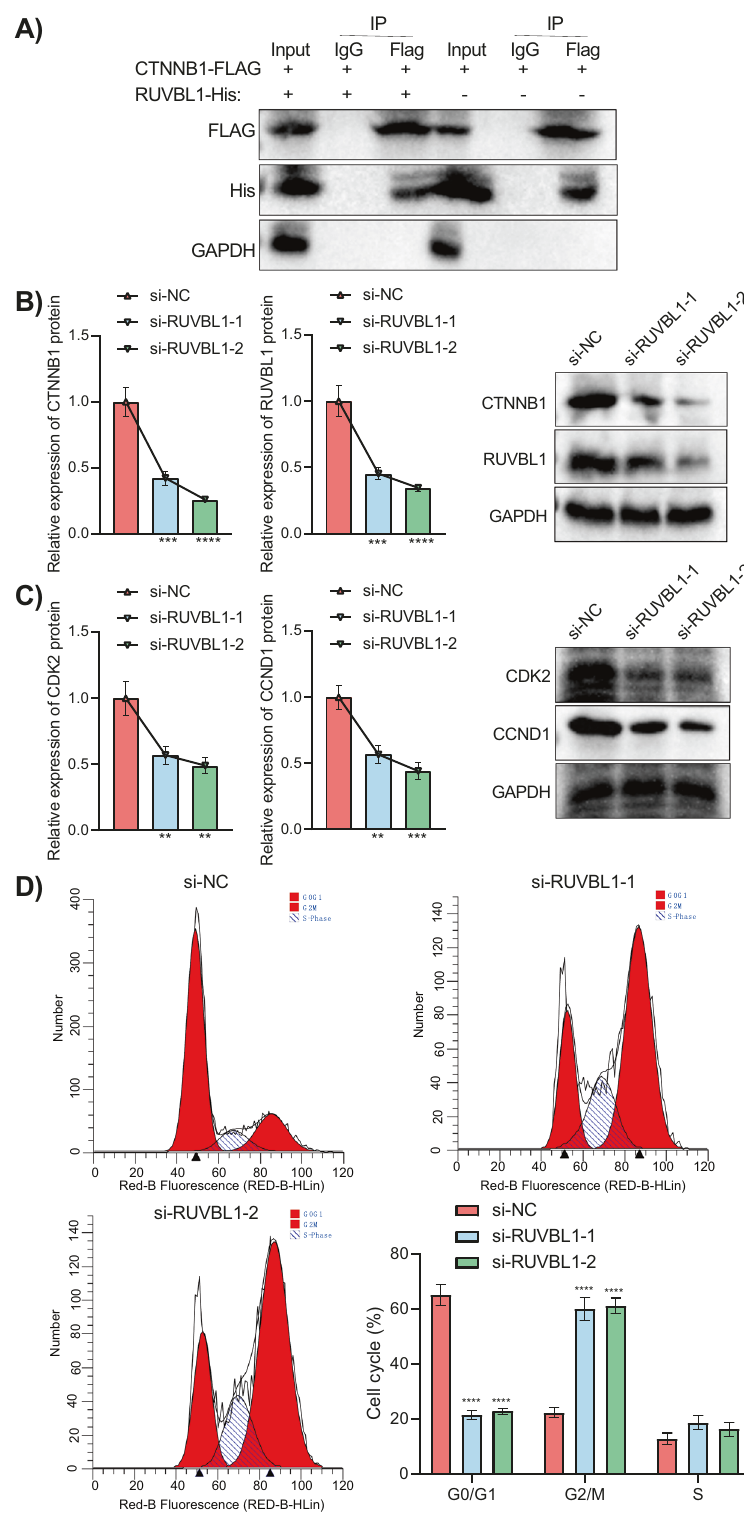
Fig. 6 Effect of RUVBL1 knockdown-mediated CTNNB1 transcriptional activity on the UVM cell cycle. A Western blot analysis on the co-IP assay of the relationship between RUVBL1 and CTNNB1. RUVBL1, or CTNNB1 was immunoprecipitated with anti-his or anti-Flag and immunoblotted for the indicated proteins. B RUVBL1 or CTNNB1 expression determined by Western blot analysis after transfection with si- RUVBL1-1 and si-RUVBL1-2. ** p < 0.01, *** p < 0.001. C CDK2 or CCND1 protein levels determined by Western blot analysis after transfection with si-RUVBL1-1 and si-RUVBL1-2. ** p < 0.01, *** p < 0.001. D Flow cytometric detection of cell cycle distribution after transfection with si- RUVBL1-1 and si-RUVBL1-2. **** p < 0.0001. The comparison of the data between the above groups was performed by